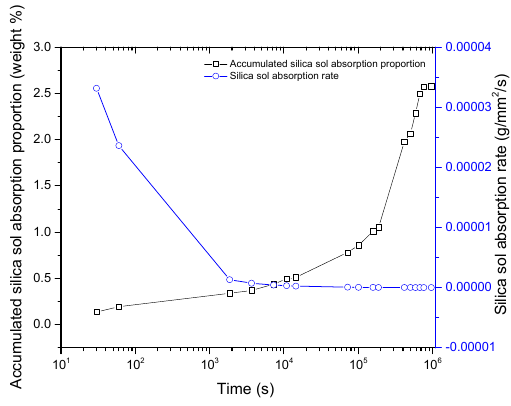
Figure 10. Silica sol content of the sample in the whole experiment.